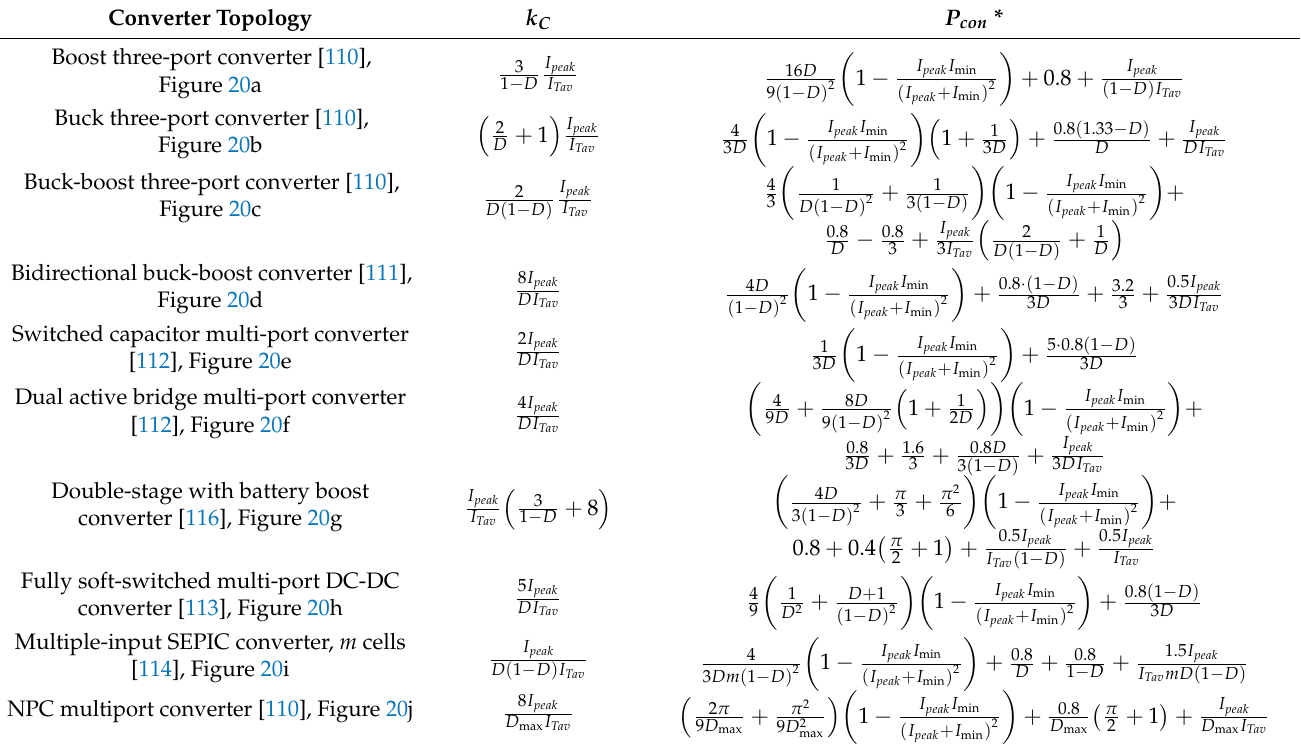
Table 9. A comparative analysis of the effectiveness of the hybrid